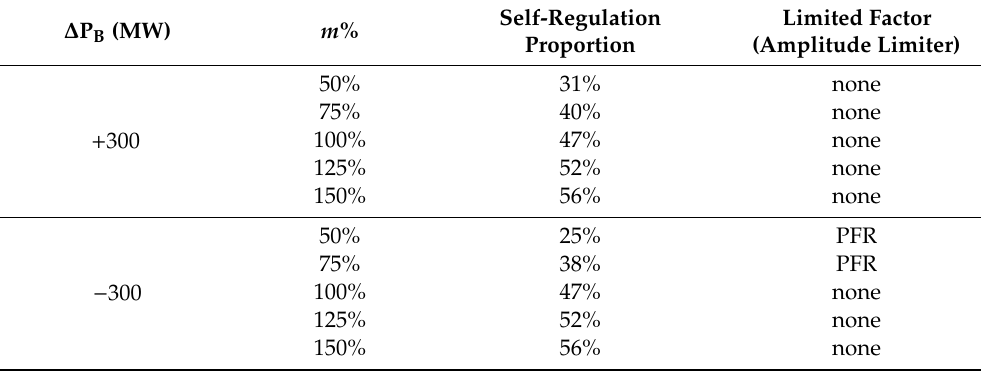
Figure 13. The Steps of the MTDC twenty-four-hour simulation program.